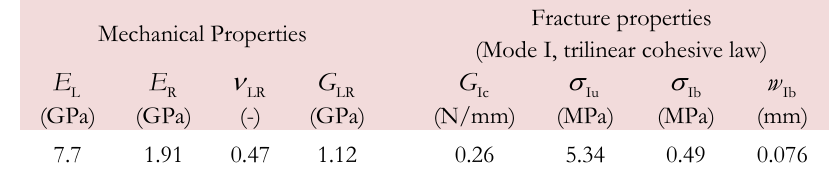
Table 1: Mechanical and fracture properties of P. pinaster used in the finite element analyses of the DCB test.